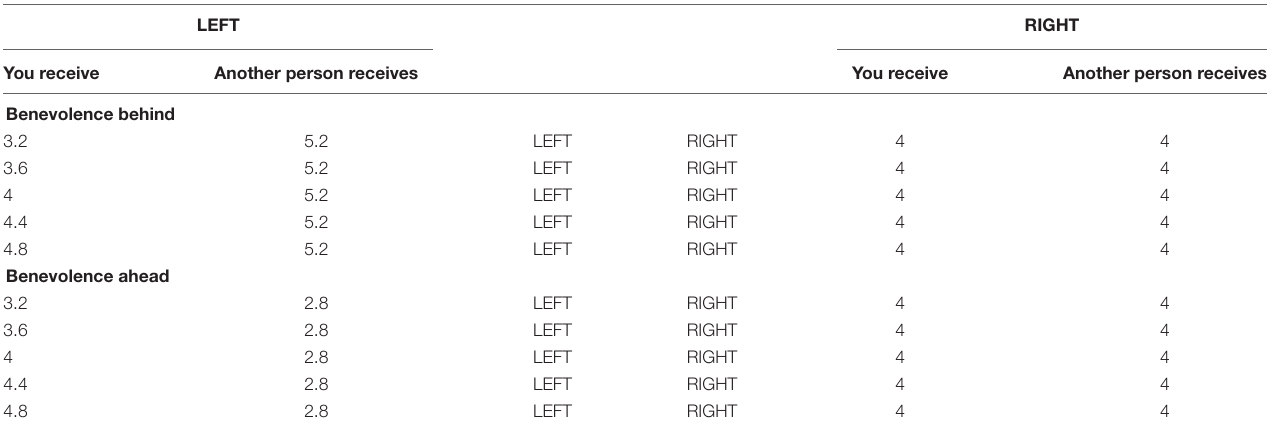
TABLE 3 | Equality Equivalence Test